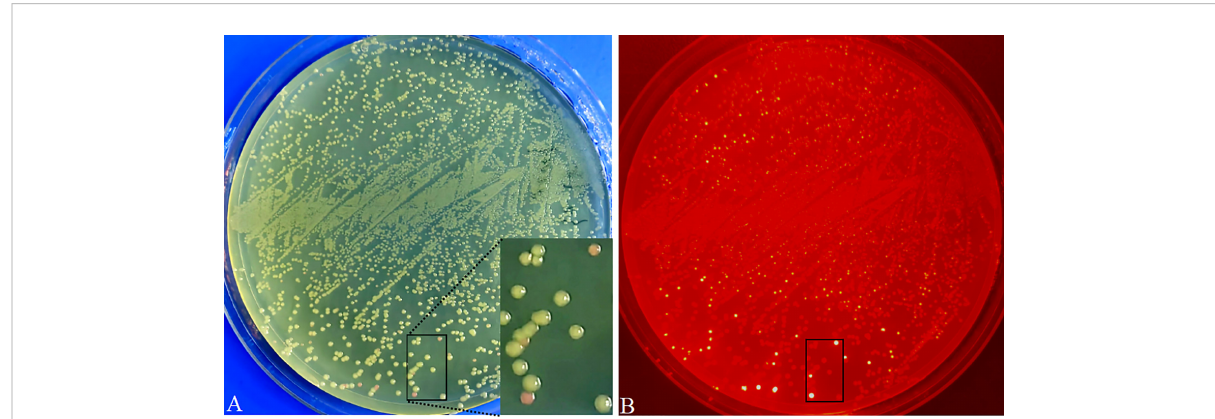
FIGURE 5 Visual screening of positive recombinants and cloning ef fi ciency analysis in E coli transformed with pR35BTR2- GmbHLH293 . Directly visual screening of recombinants by the naked eye under natural light. Positive recombinants are white color, while non-recombinants are reddish-